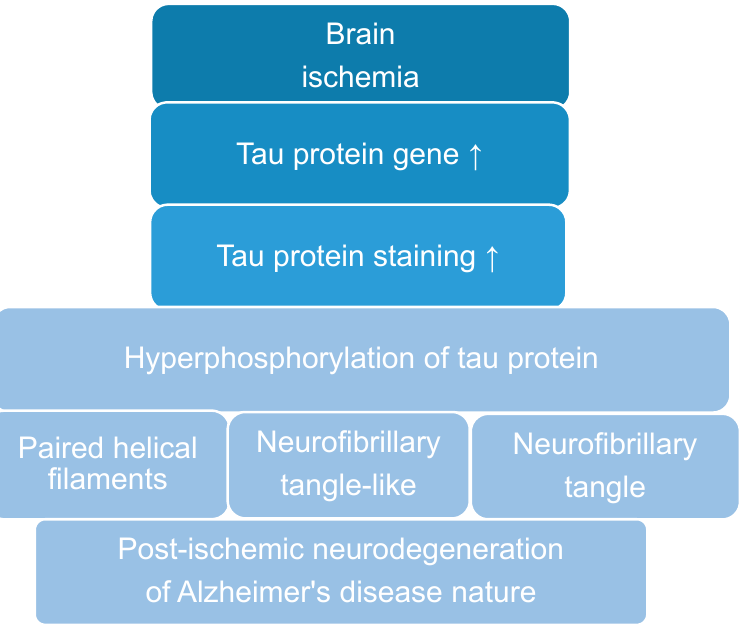
Figure 1. The role of post-ischemic tau protein in brain neurodegeneration. ↑ –increase.